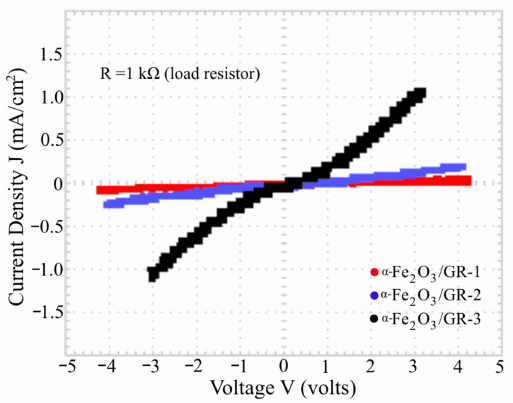
Figure 5. Current–voltage plots in Fe–Si steel/ α -Fe 2 O 3 /graphite structures to measure electrical conduction of three different